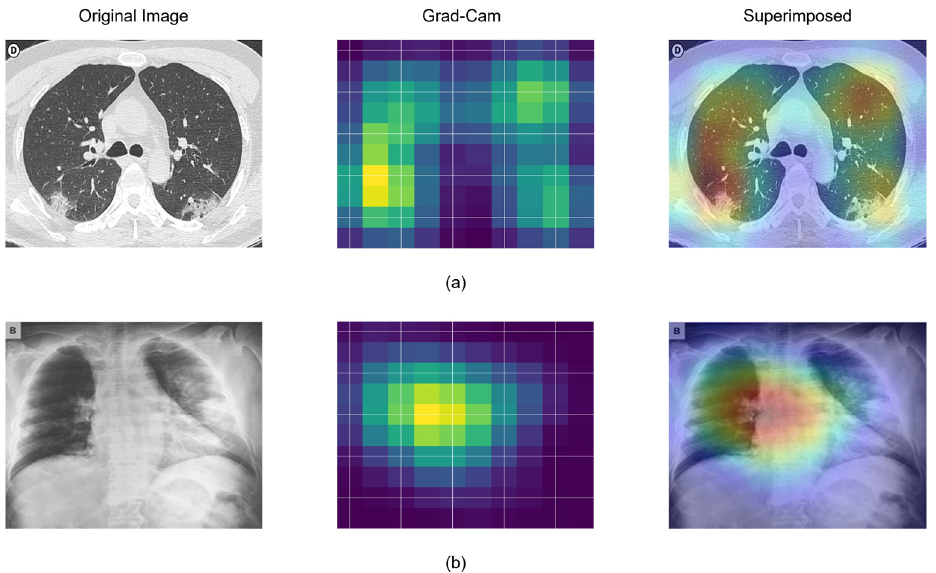
Figure 9. Grad-Cam visualization of the proposed SCovNet model for COVID-19 positive patient ( a ) CT scan and ( b ) CXR image.